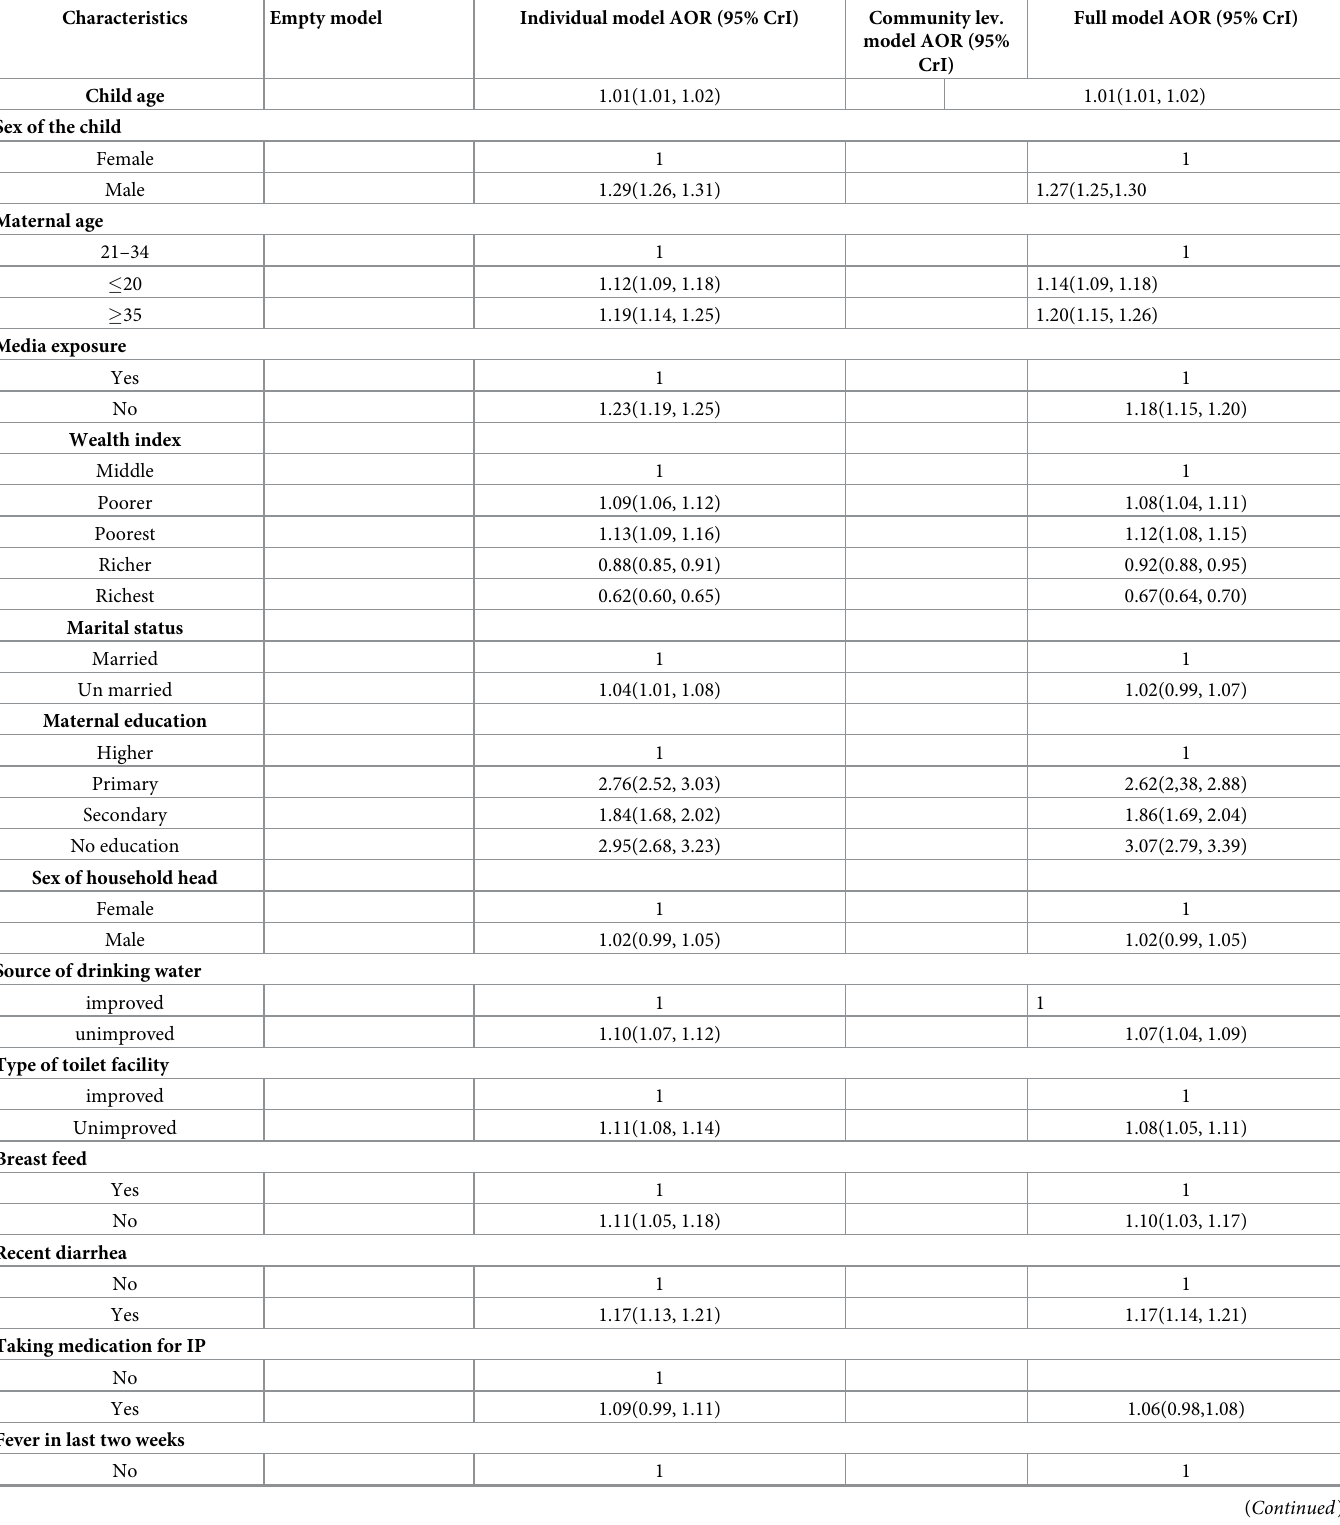
Table 2. Multivariable binary logistic regression analysis based on hierarchical Bayesian statistical approach result of both individual and community level factors associated with stunting of children: From recent DHS of 35 SSA countries, 2008–2020.